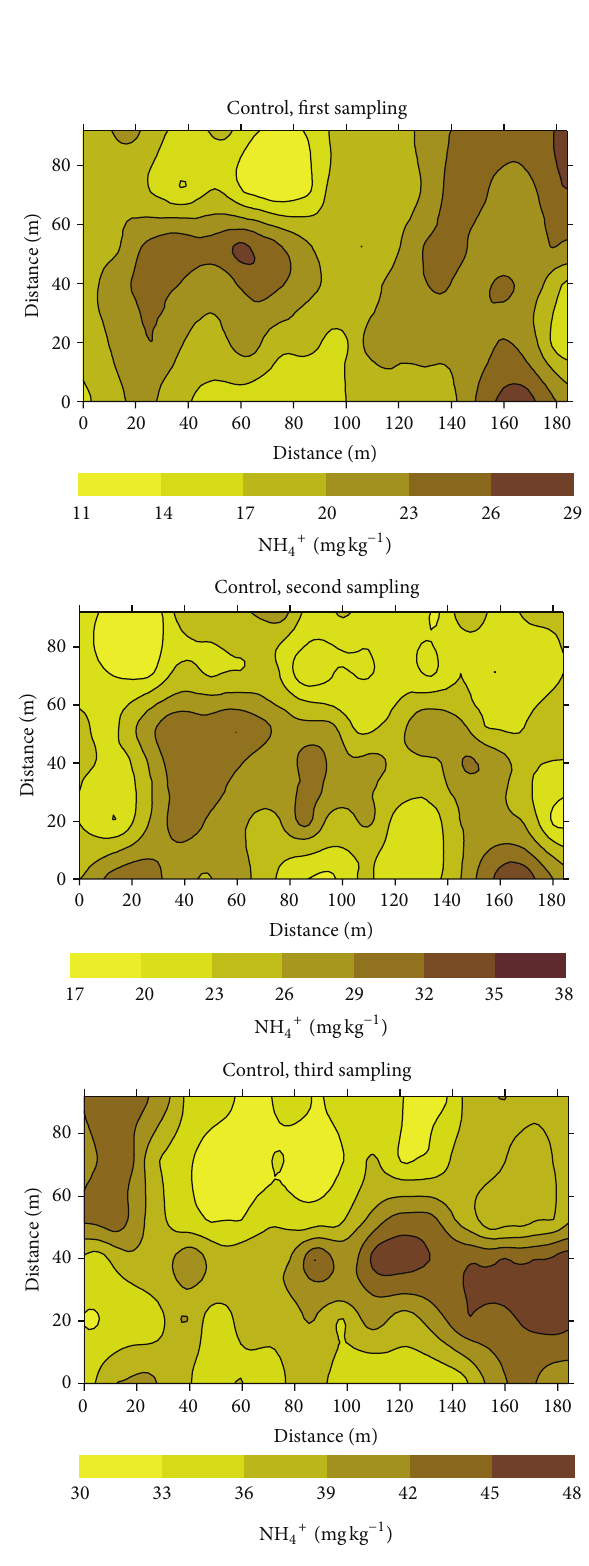
Figure 4: Kriging maps for ammonium-nitrogen (NH 4+ -N) at the control treatment, for successive sampling